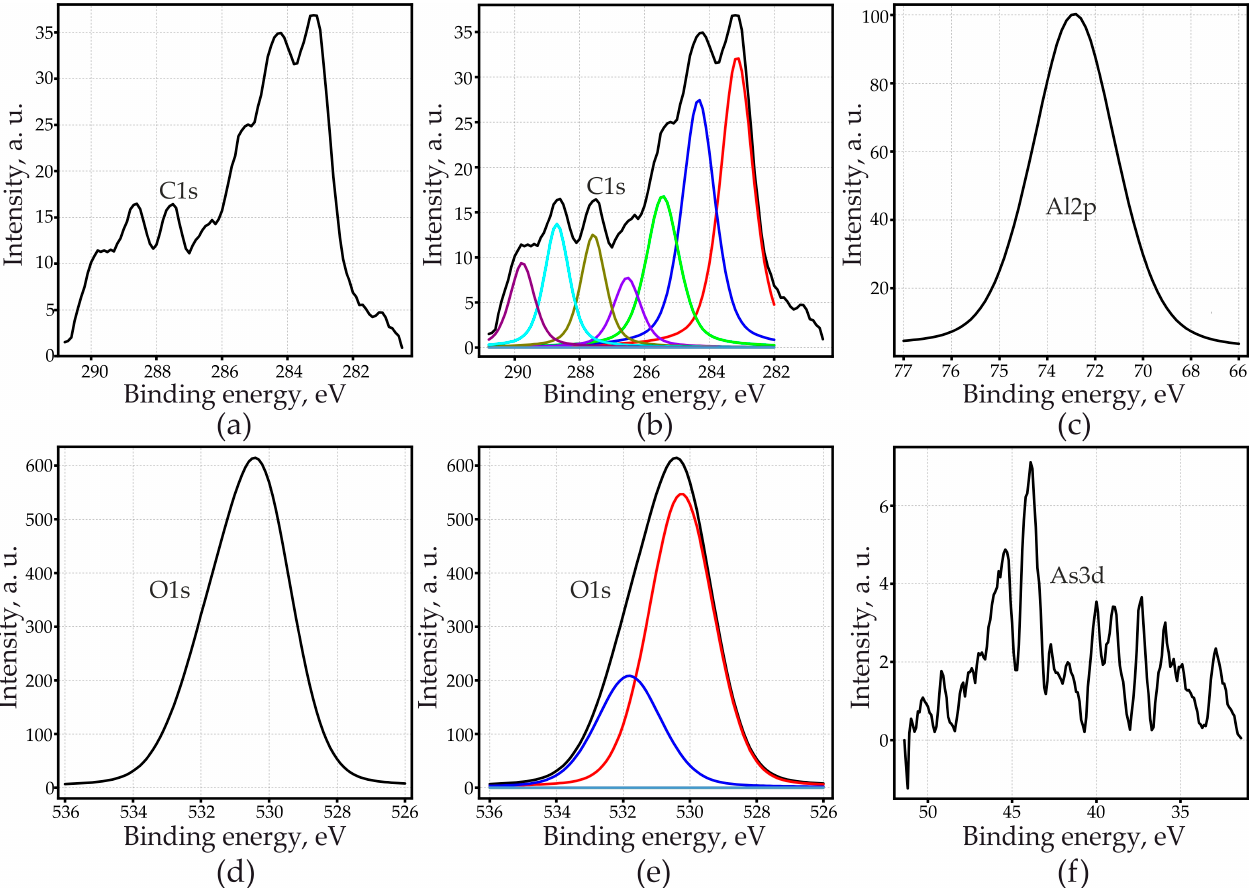
Figure 8. XPS-peaks of porous aluminum oxide films, measured after 40 min of sputtering ( j a = 200 mA·cm − 2 ; 2.5 g·L − 1 arsenazo-I): ( a ) C1s; ( b ) deconvolution of C1s-peaks; ( c ) Al2p; ( d ) O1s; ( e ) deconvolution of O1s-peak; ( f ) As3d.